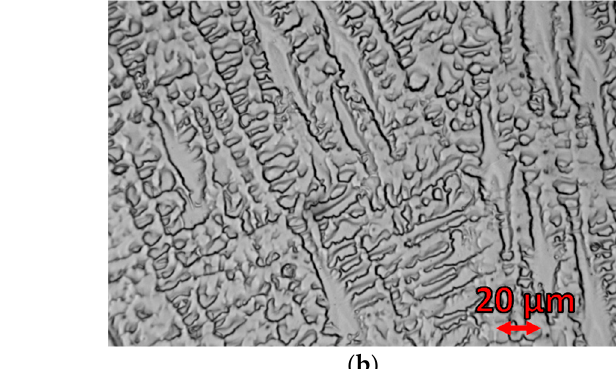
Figure 9. Mixed joint fusion line: ( a ) fusion line from the S355J2W+N steel side, ( b ): fusion line from the Alloy 59 side.